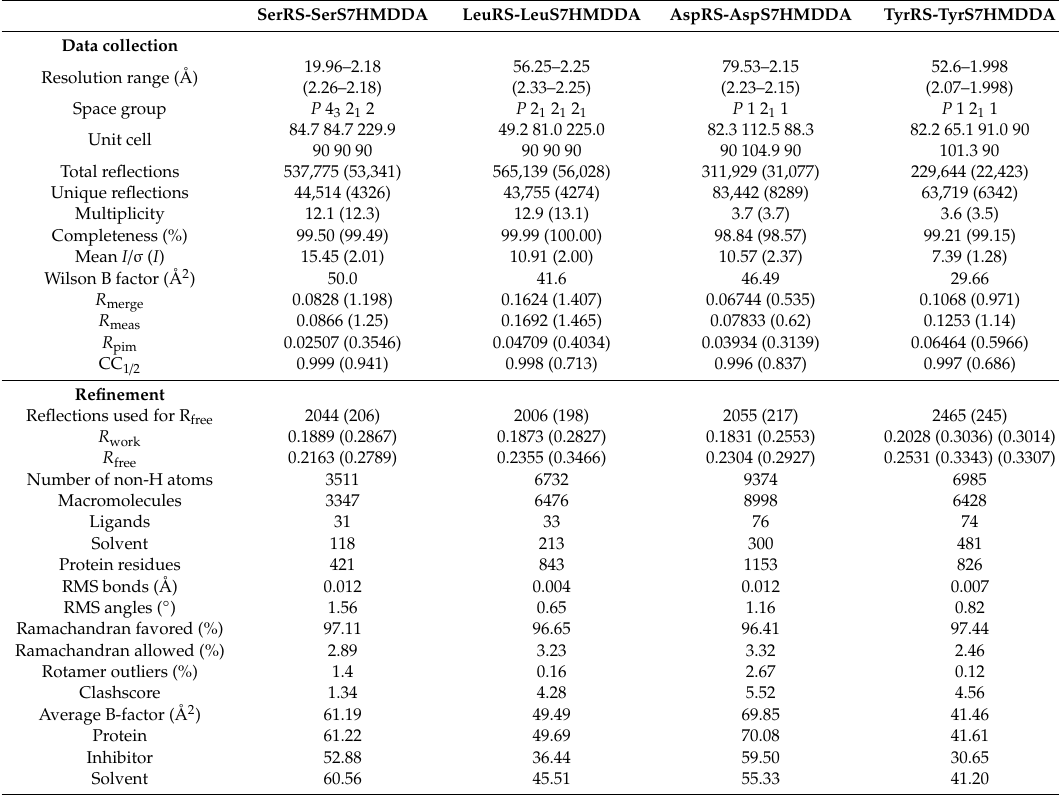
Table 2. Data collection and refinement statistics for the crystal structures of aaRS in complex with